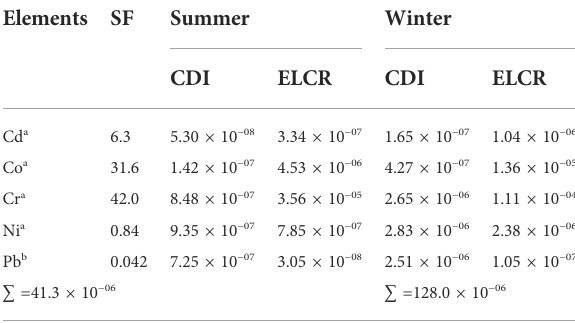
TABLE 2 Estimated cancer human health risks for scenarios during summer and winter. Elements SF